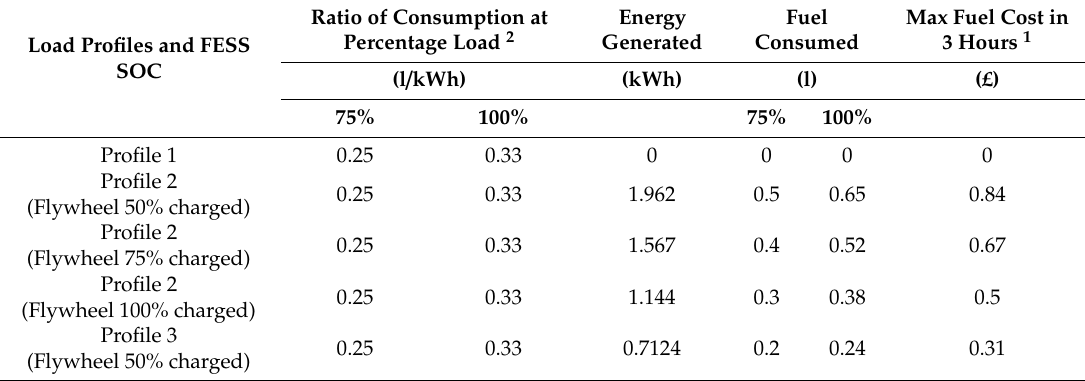
Table 2. Diesel generator fuel consumption.